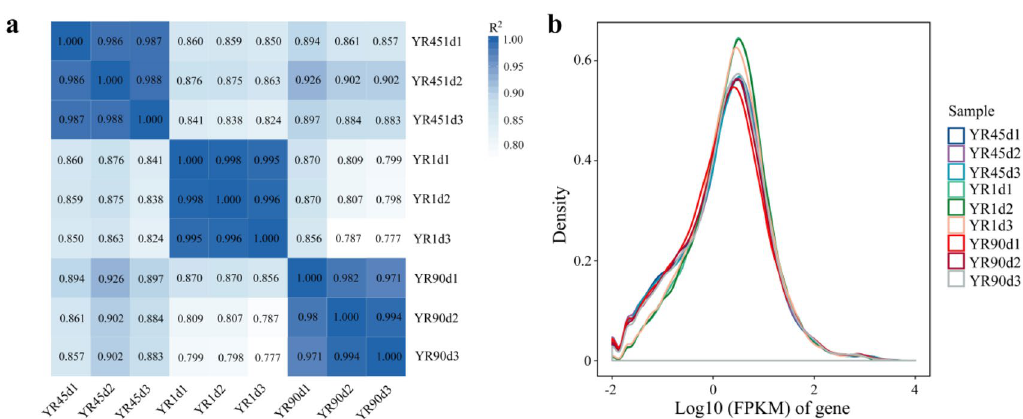
Figure 1. ( a ) Heatmap of Pearson correlation between samples. The number in the boxes refer to Pearson’s correlation coefficients (R 2 ), and the closer R 2 is to 1, the higher degree of correlation between samples. ( b ) Distribution of gene expression abundance of each sample. The x-axis represents the values of log10 (FPKM) of gene, the y-axis represents the number of genes corresponding to the value of the x-axis/the total number of